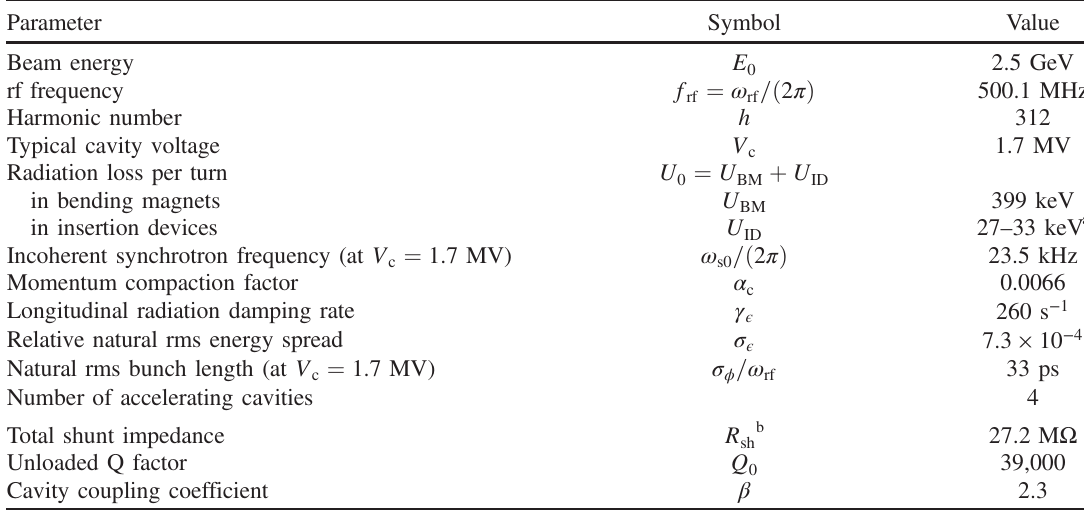
TABLE I. The principal parameters of the PF storage ring [19,20] together with the definitions of